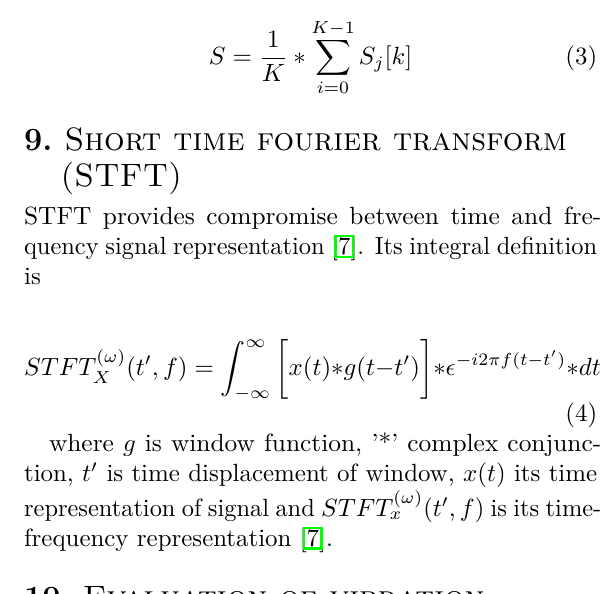
Figure 4. The three-axis accelerometer placed on flange of the wing